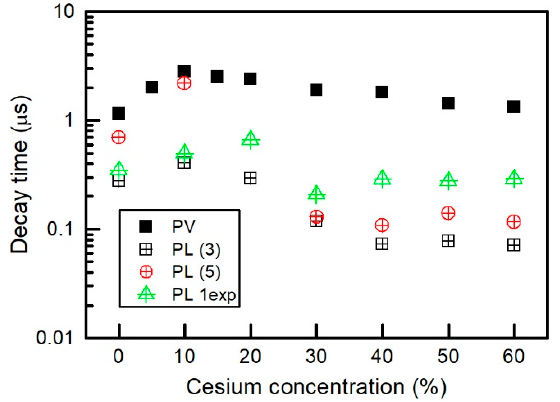
Figure 8. Dependence of photovoltage (PV) and photoluminescence (PL) decay time constant on cesium concentration in the perovskite layer.